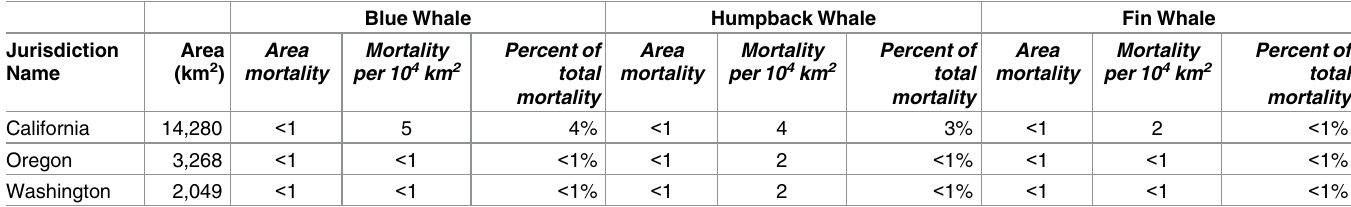
Table 8. Mortality within sovereign waters (3 Nm offshore) for each of the three west coast states, California, Oregon and Washington. Mortality per 100,000km 2 and percent of total study area mortality are also reportedfor each state. Blue